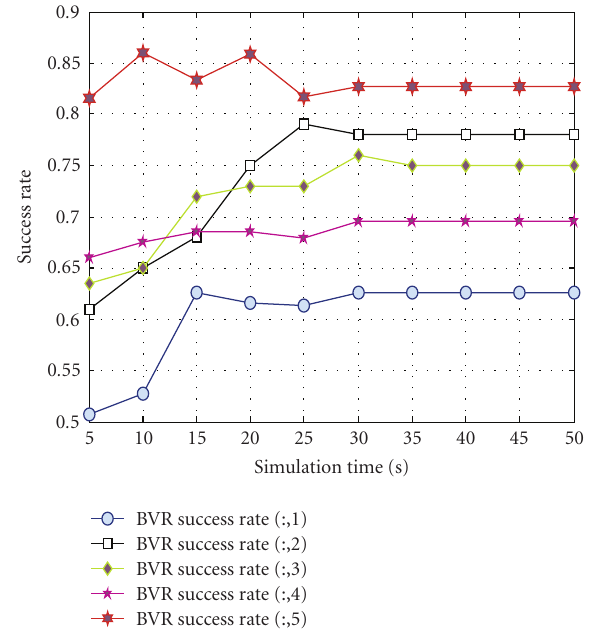
Figure 11: Simulation time and success rate.